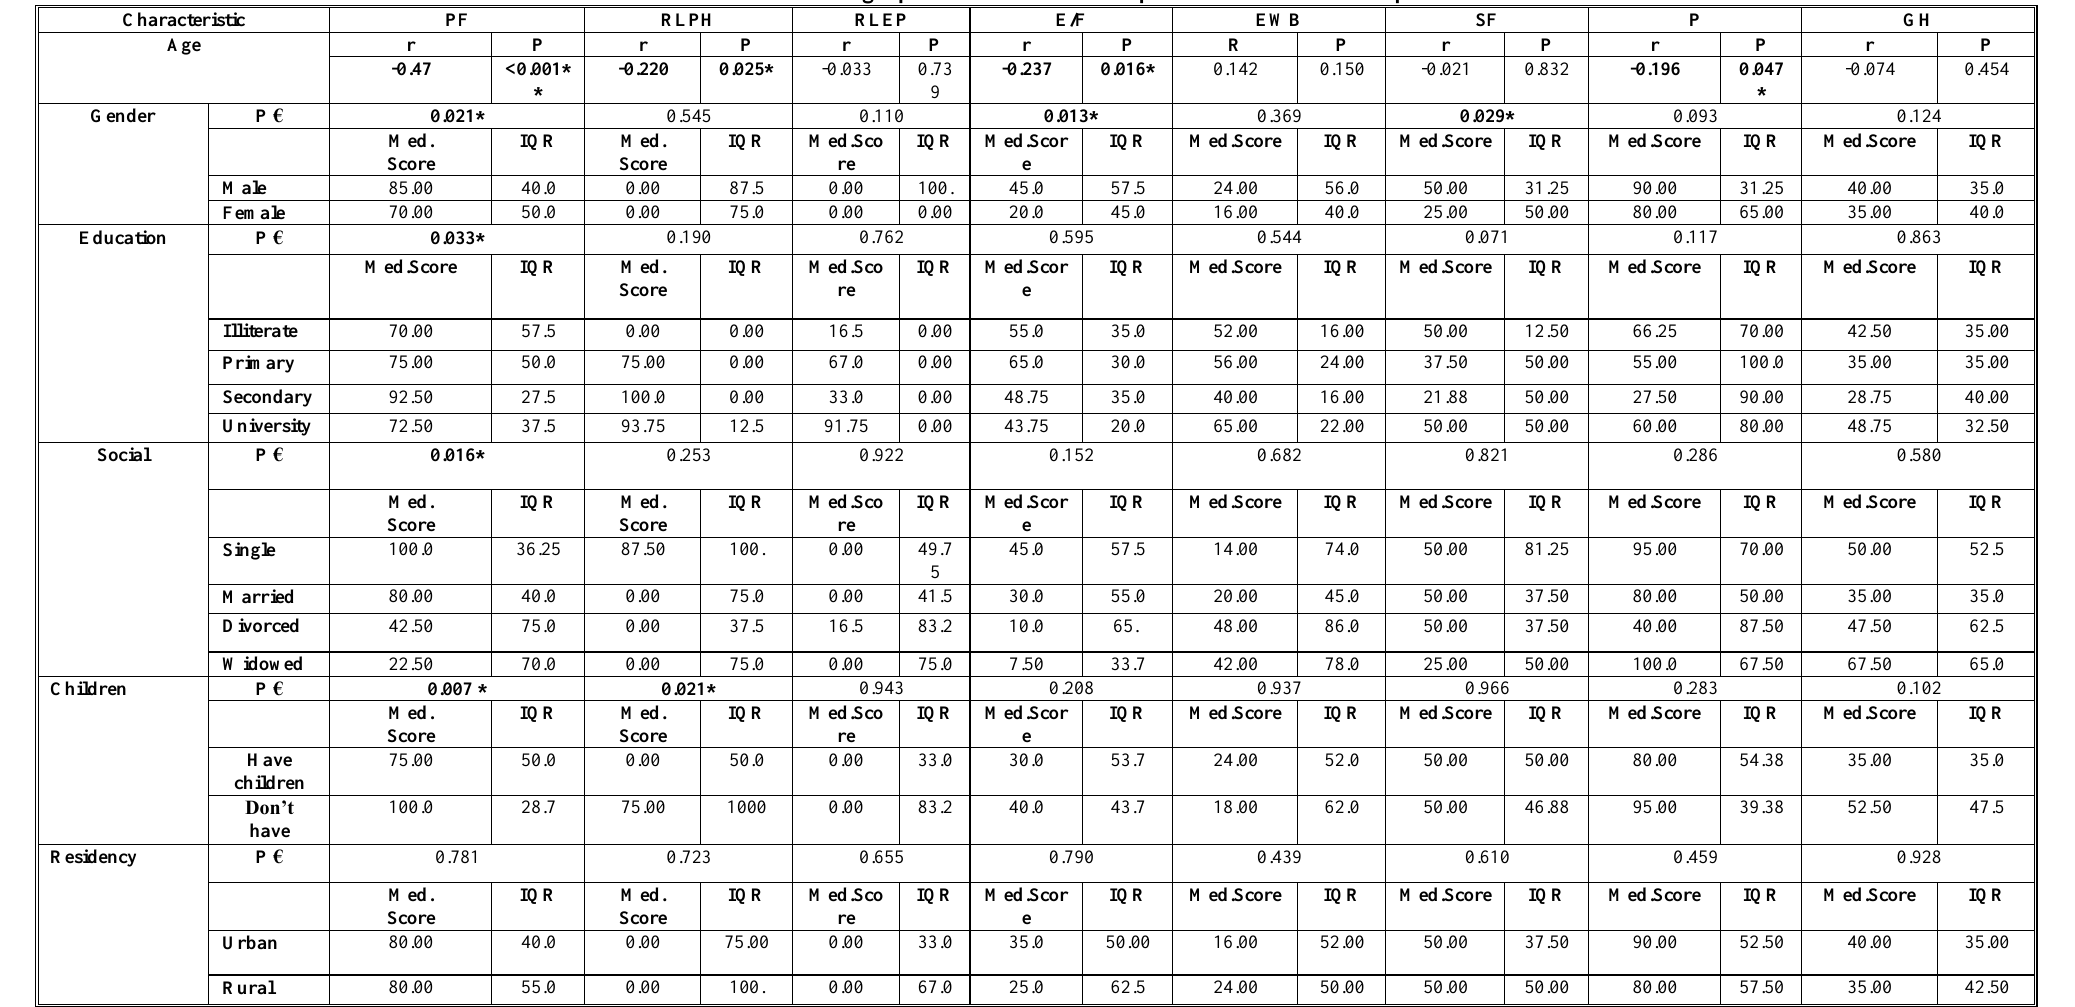
Table 4.Distribution and correlation of short form domain scores and demographic characteristics of patients with chronic hepatitis B infection.